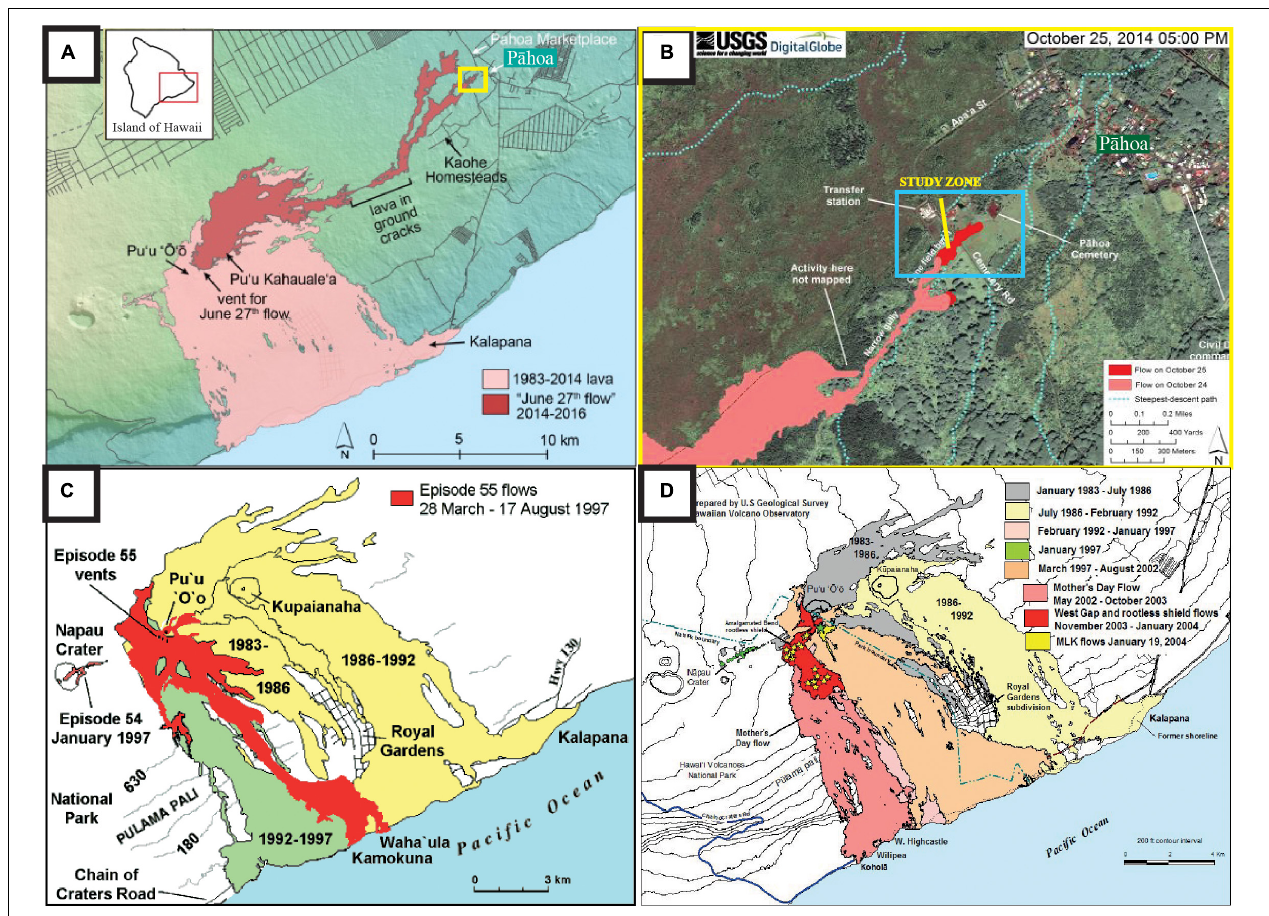
FIGURE 1 | (A) Map of the “27th June” 2014-2016 lava flow field within the context of the Pu’u ’O’o-Kupaianaha lava flow field (courtesy of USGS Hawaiian Volcano Observatory); location of map on the Big Island of Hawaii is given as inset (yellow box gives the enlargement given in (B) . (B) Flow front positions of the “27th June” lava flow approaching P¯ahoa the day before (24 October 2014) and after (25 October 2014) it engulfed the studied Albizia tree (map courtesy of Matthew Patrick, USGS Hawaiian Volcano Observatory). Blue box gives fields of view of helicopter-based photos given in Figure 3 . (C,D) Maps of the Pu’u ’O’o-Kupaianaha lava flow field as of August 1997 and January 2004 (courtesy of USGS Hawaiian Volcano